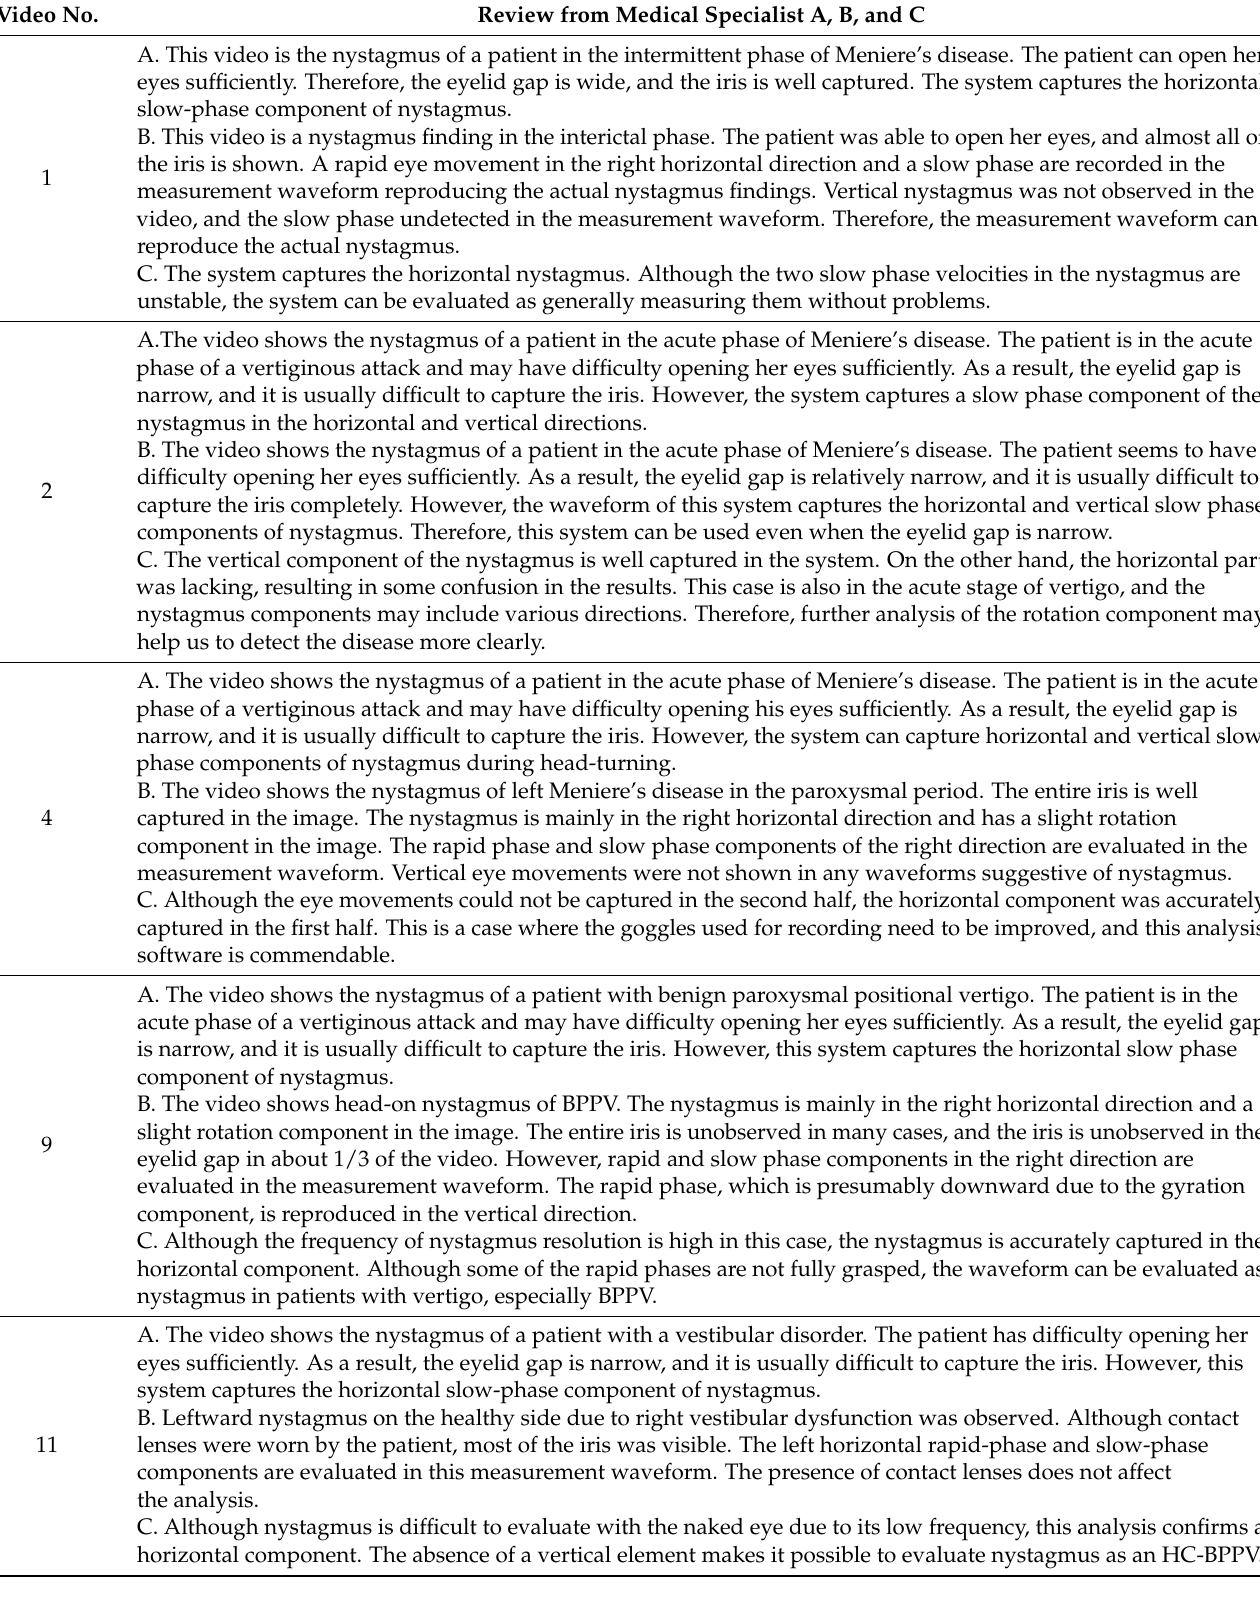
Table A2. Summary of medical specialist